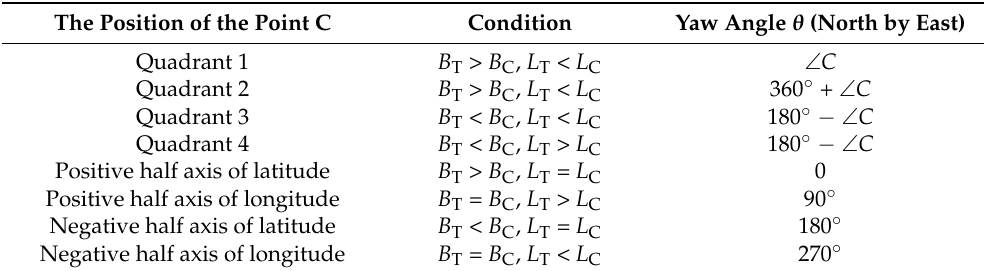
Table 1. True value of the yaw angle.